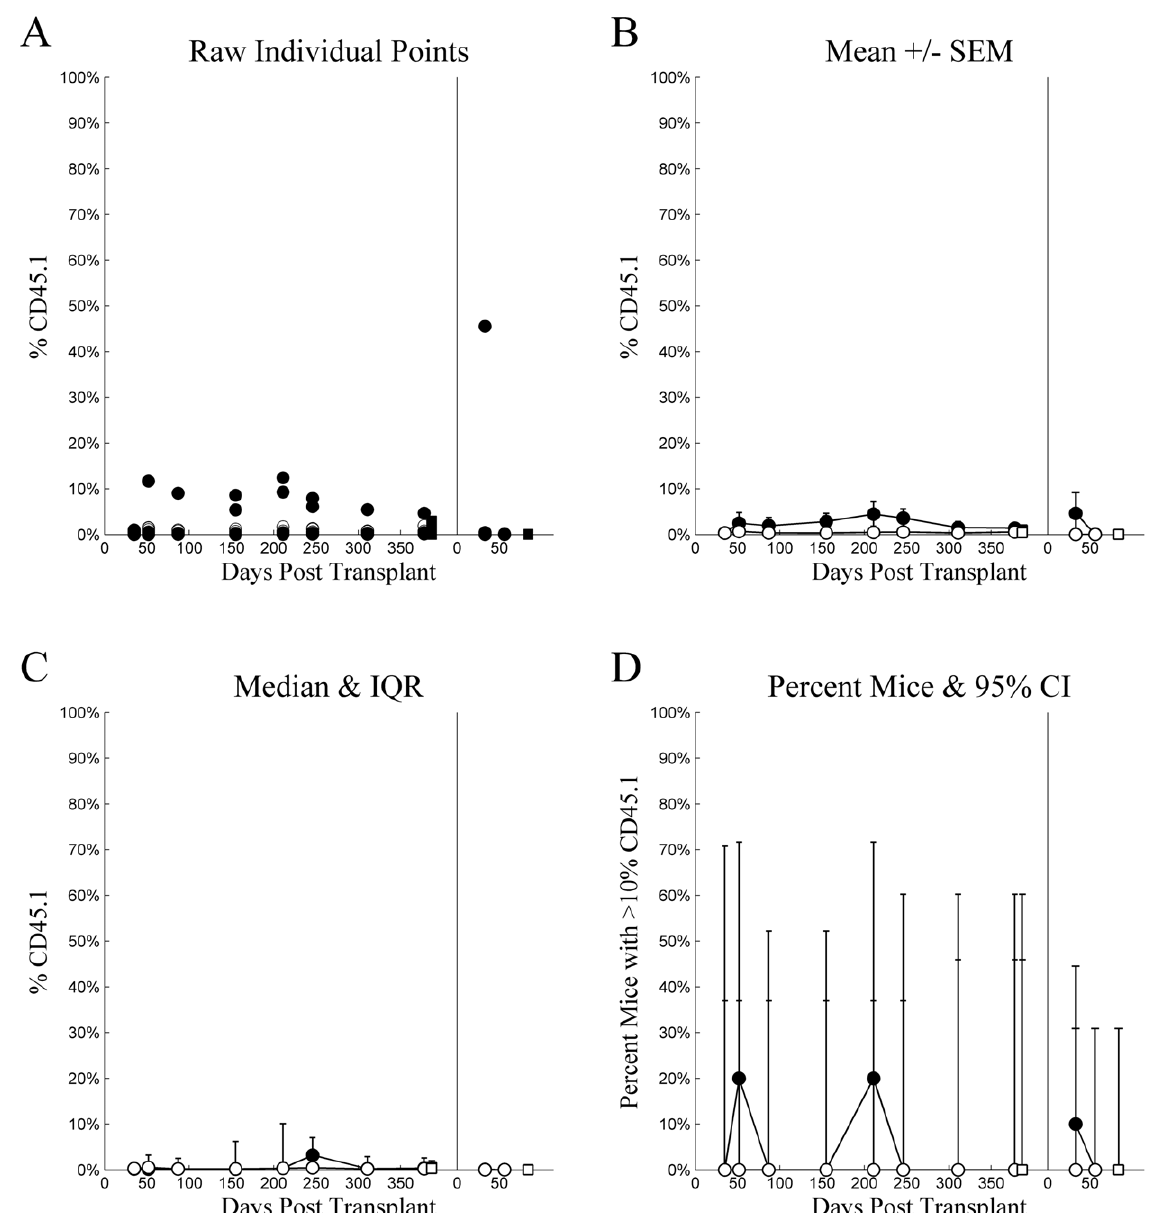
N N Figure 3. Experiment 1: intraperitoneal injection. Chimerism (%CD45.1) (ordinate) plotted as a function of Days Post Transplant (abscissa), type & : LT-HSC, #% : ST-HSC), and source ( # : whole blood, &% : whole bone marrow) for several different methods of summary: A) of cells injected ( raw individual mouse percent CD45 cells that were CD45.1, B) mean 6 standard error of the mean, C) median with inter-quartile range, and D) percent of mice with greater than 10% of CD45 cells being CD45.1. For each tile, the data from the primary transplant is plotted on the left and secondary transplant on the right, separated by a vertical line at zero for the secondary transplant.